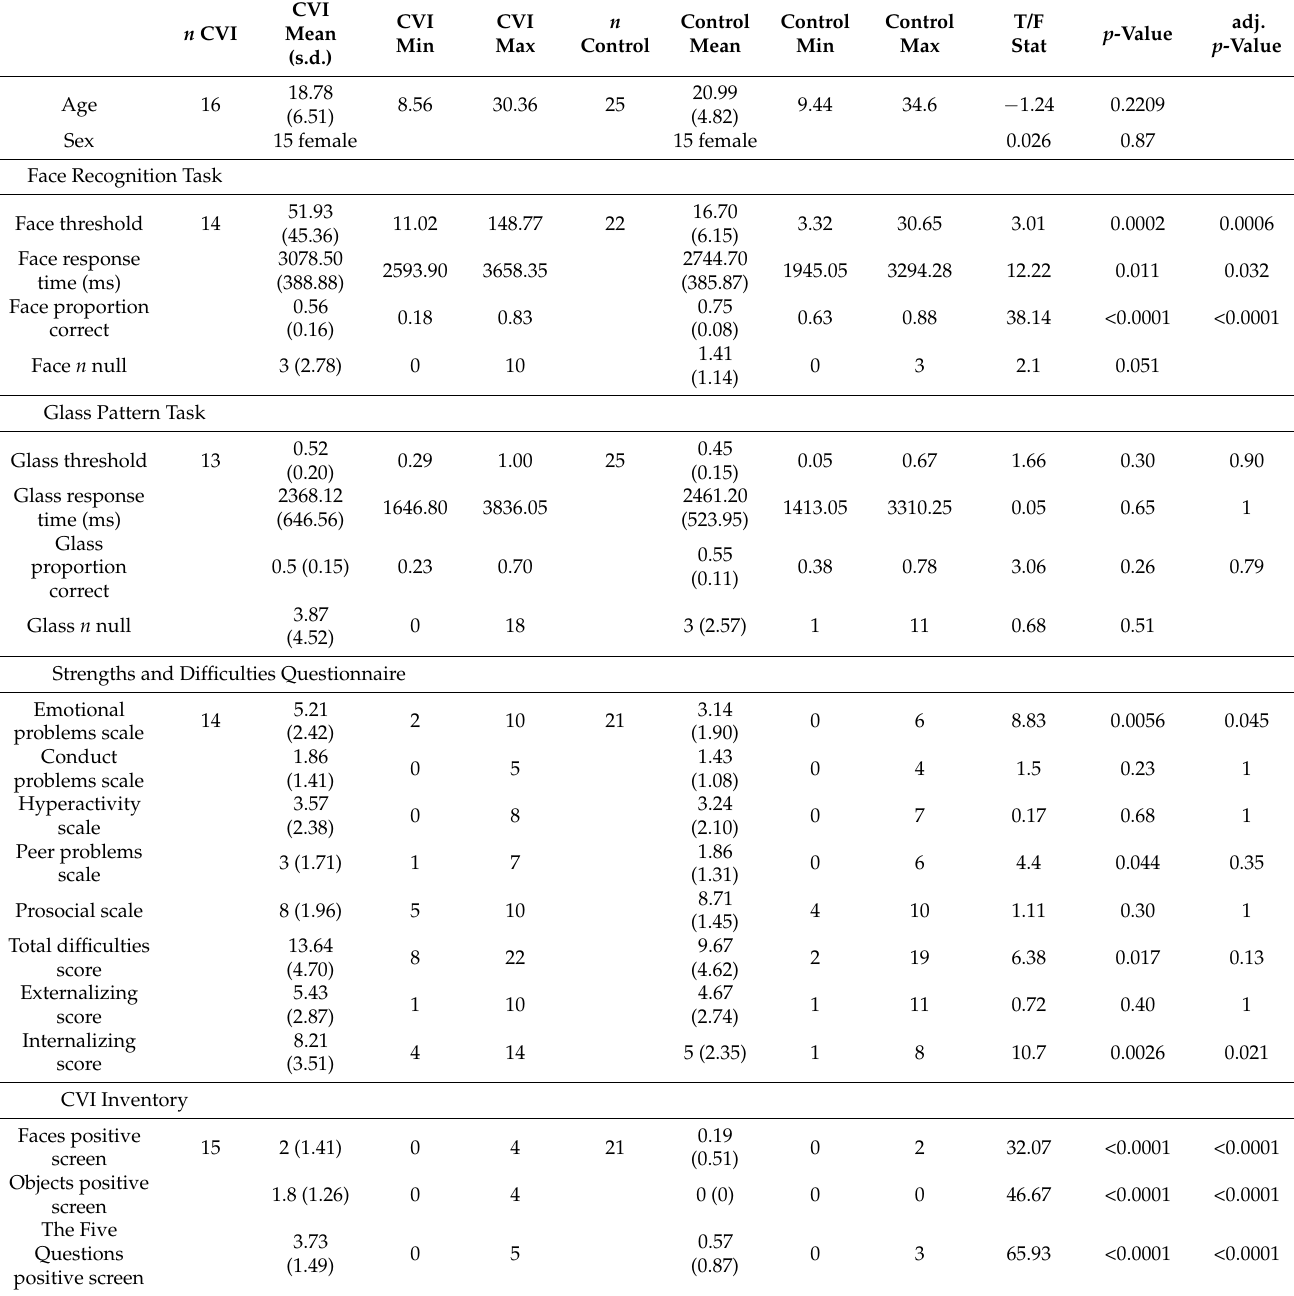
Table 1. Participant demographic information for the CVI and control groups. Group mean, standard deviation (s.d.), and range values are also provided for the face recognition task, glass pattern task, Strengths and Difficulties Questionnaire, and CVI Inventory. Where appropriate T- or F-statistics and associated p -values are